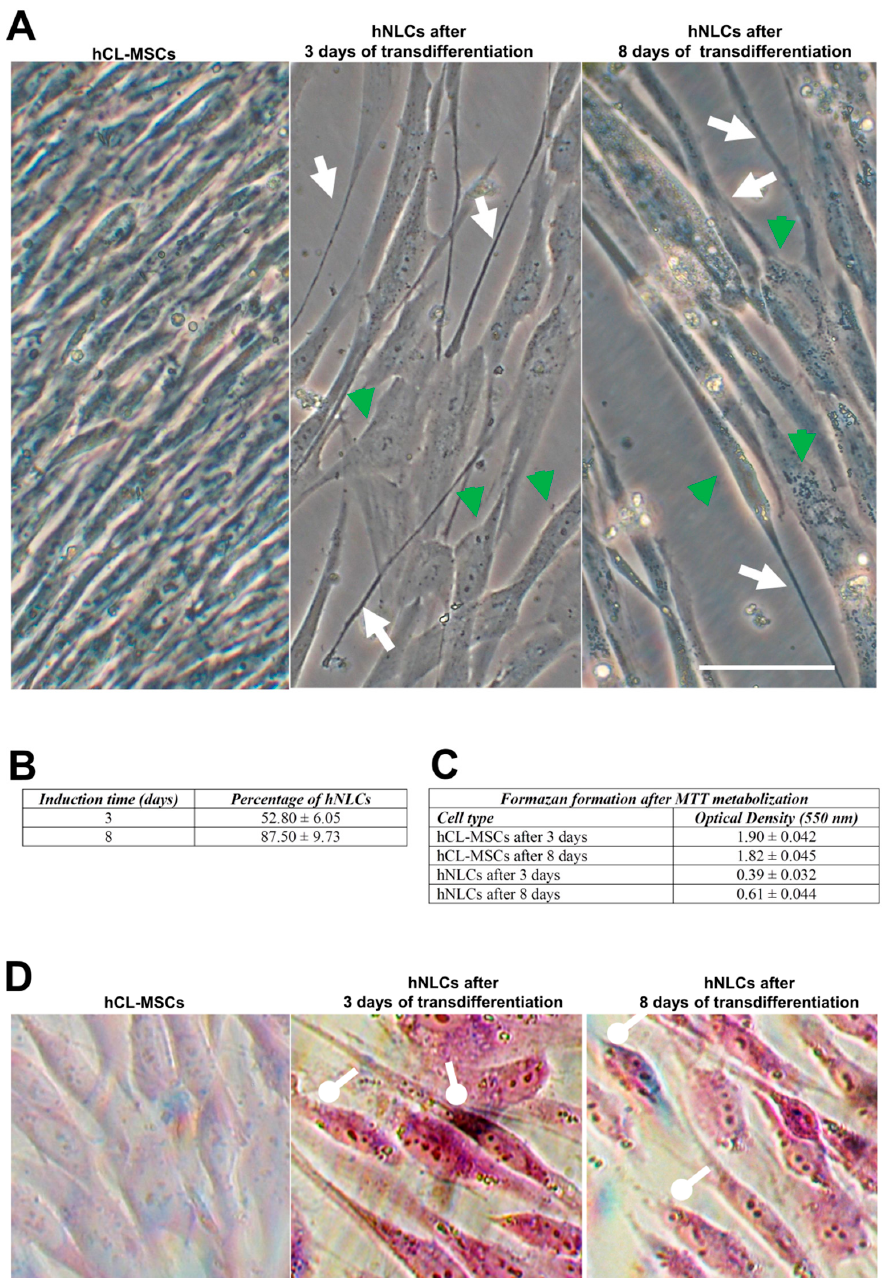
Figure3. hCL-MSCstransdi ff erentiatedintoneuronallineageatdi ff erenttimepoints. ( A )Phase-contrast analysis of hCL-MSCs transdi ff erentiated into hNLCs at di ff erent time points. Cell bodies indicate by green head arrows; elongated structures indicate by white arrows. Scale bar: 100 µ m. ( B ) Quantitative changes of hNLCs: the percentage of hNLCs was significantly increased during the induction time. Data are presented as the mean ± S.D. hNLCs at day 3 compared to day 8 of transdi ff erentiation were statistically di ff erent ( p < 0.05). ( C ) Decrease of cell proliferation capacity during transdi ff erentiation process into hNLCs (3 and 8 days). Data are presented as the mean ± S.D. ( D ) The Nissl body staining of hCL-MSCs transdi ff erentiated into neuronal lineage at di ff erent time points: di ff erently from the control (hCL-MSCs untransdi ff erentiated), the hNLCs (after 3 and 8 days) show somata-associated accumulations of the Nissl bodies stained dark black-violet (round-headed white arrows). Scale bar: 100 µ